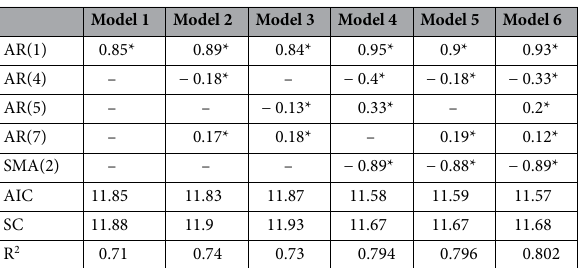
Table 2. Results of parameter tests and the AIC, SC, and R 2 values of the six models of passed parameter tests. *Means significant at 0.05